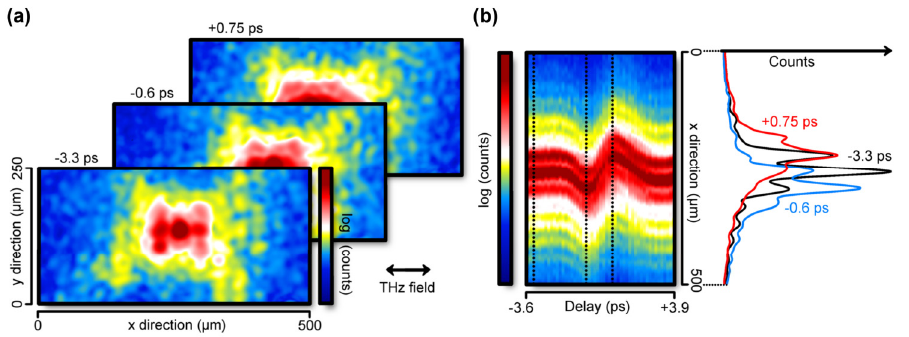
Fig. 2. Experimental time-resolved diffraction. (a) Electron diffraction patterns for different THz- electron delays. (b) Diffraction results integrated along the y direction showing the single-cycle THz characteristics in the global deflection and delay-dependent Bragg spot intensity